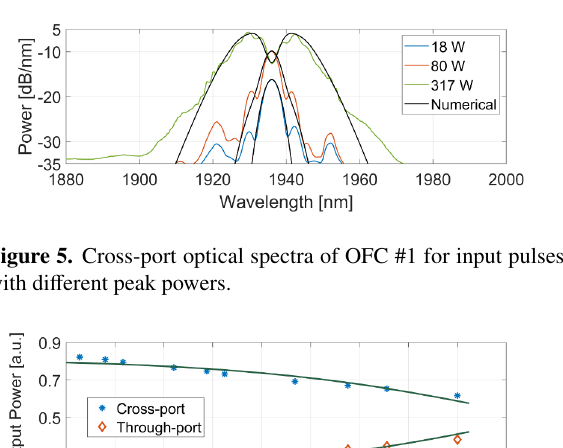
Figure 4. (a) Output power of OFC #1 as a function of the input peak power. (b) Relative output power of OFC #1.